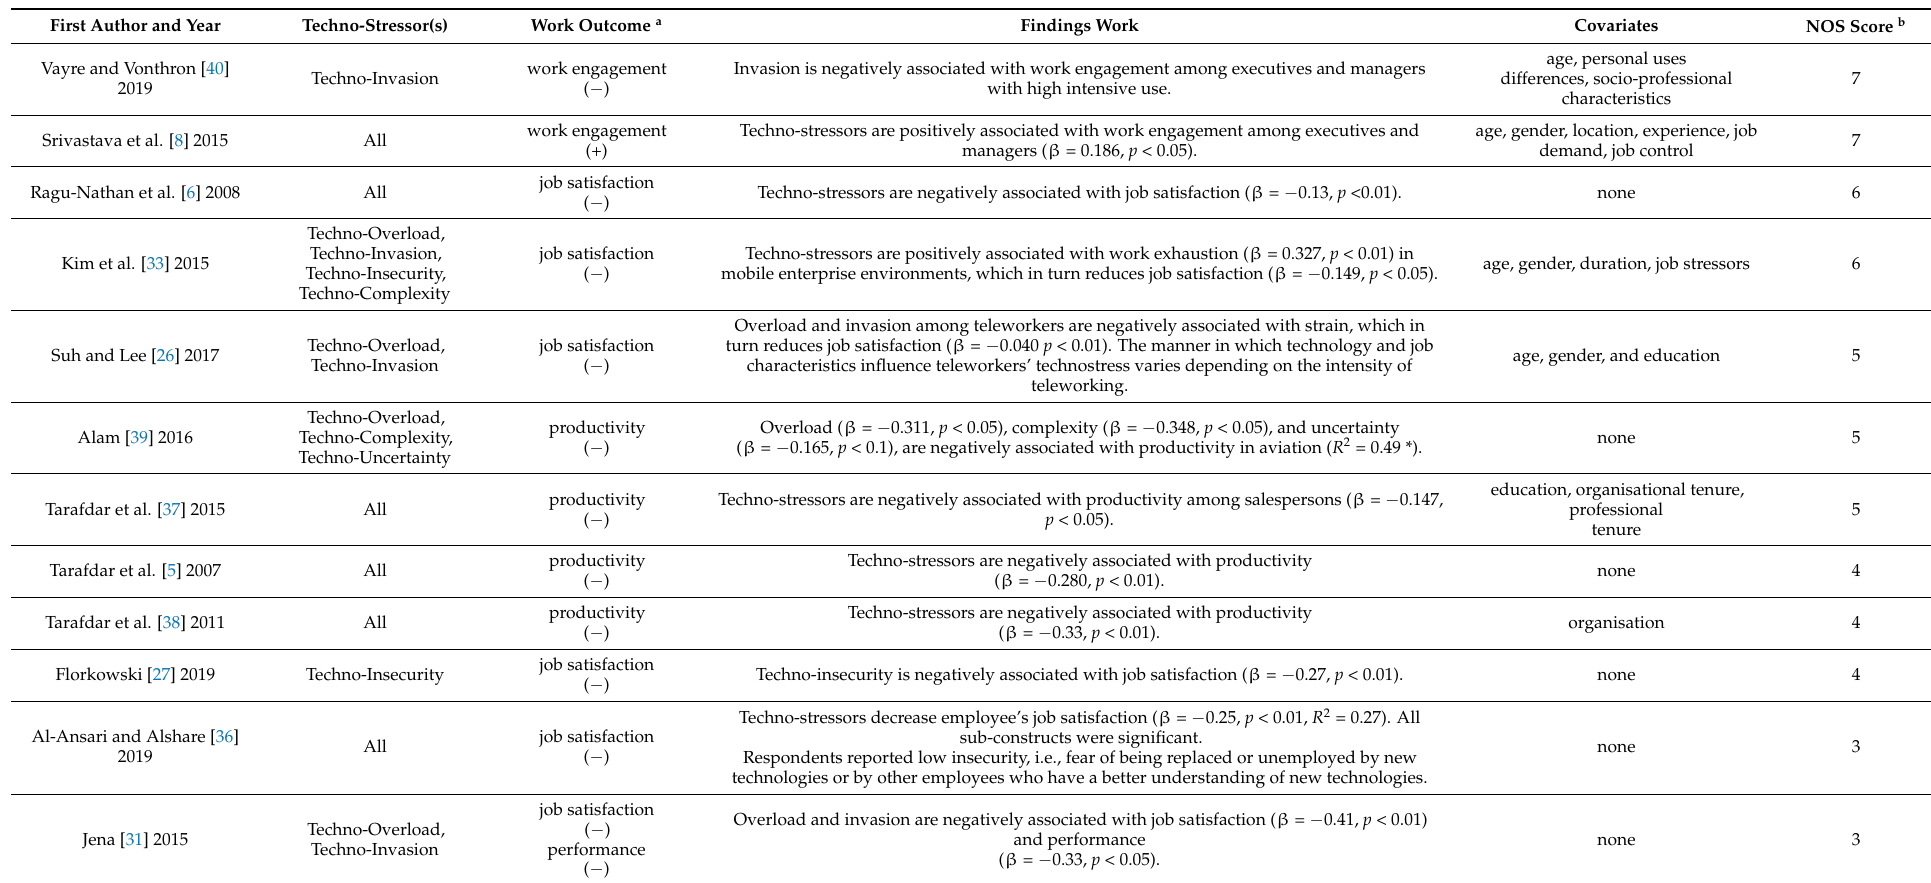
Table 2. Findings on work outcomes (sorted by NOS